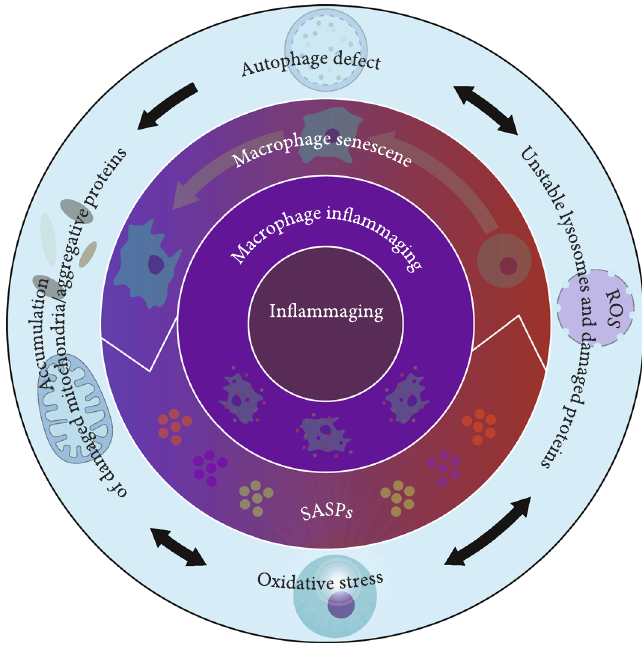
Figure 2: Schematic of the two vicious